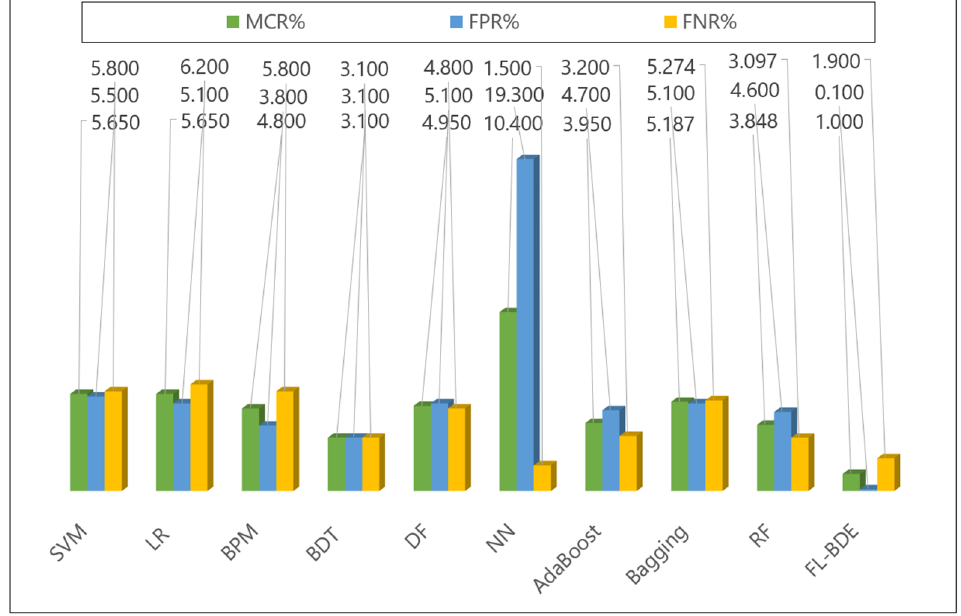
Figure 8. Error rates of FL-BDE, ML- and EL-based models for 5-fold cross-validation.